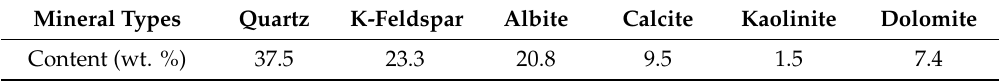
Table 1. The mineral composition of synthetic core